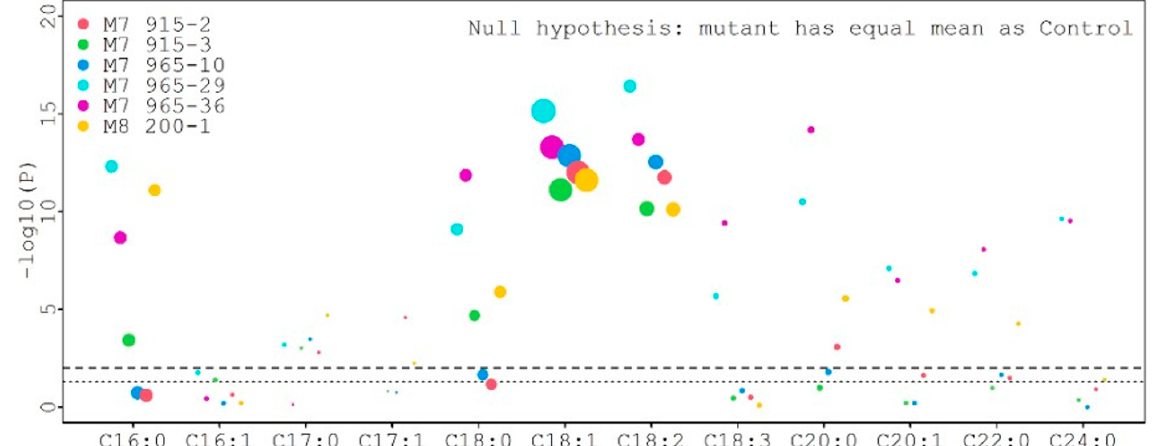
Figure 7. Comparison of each fatty acid value from all mutants with the control.